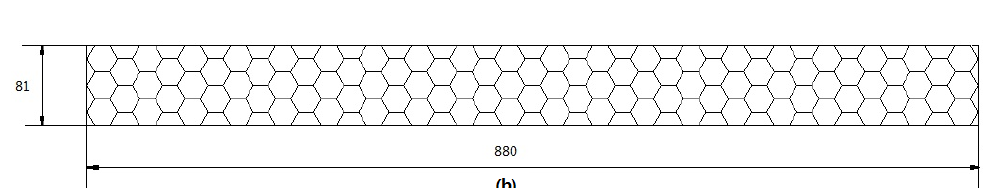
Figure 4. Cell configuration and design of the honeycomb sandwich blast wall (HSBW). ( a ) honeycomb unit cell, ( b ) honeycomb layout.